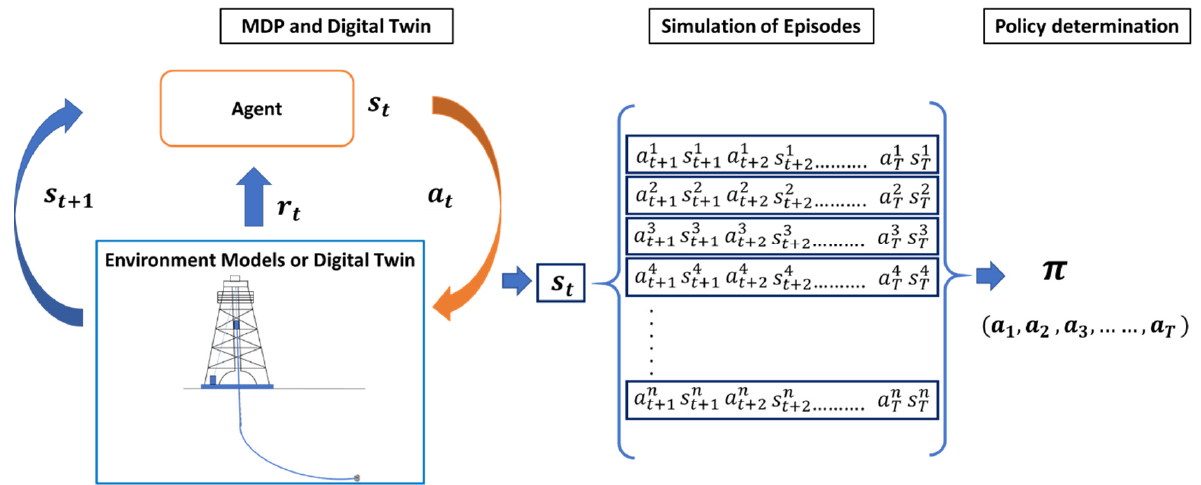
Figure 3. Application of MDP and digital twins for simulating episodes to determine the optimal policy.